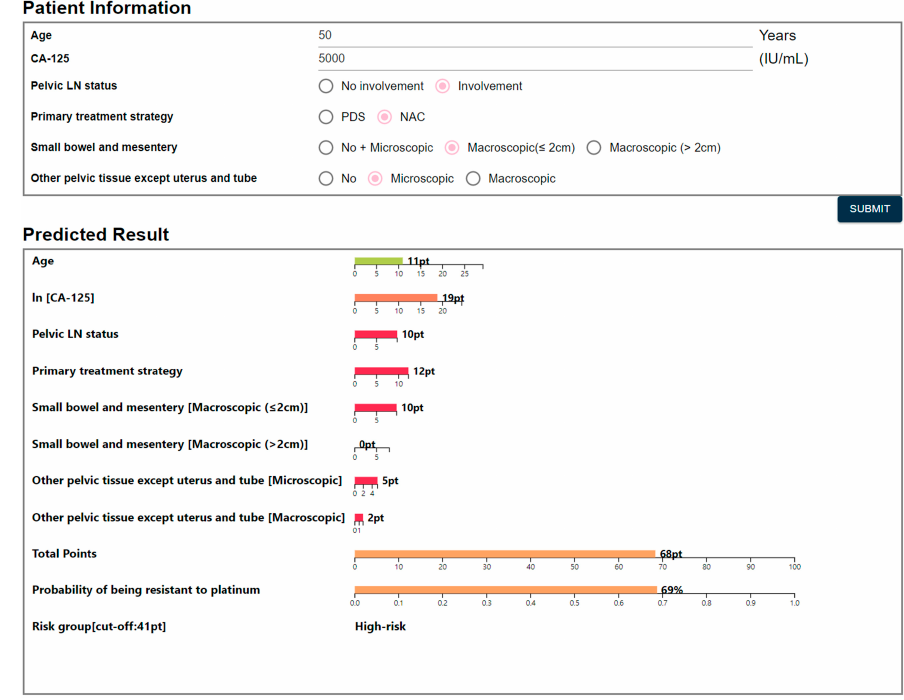
Figure 4. Web-based nomogram predicting platinum sensitivity.